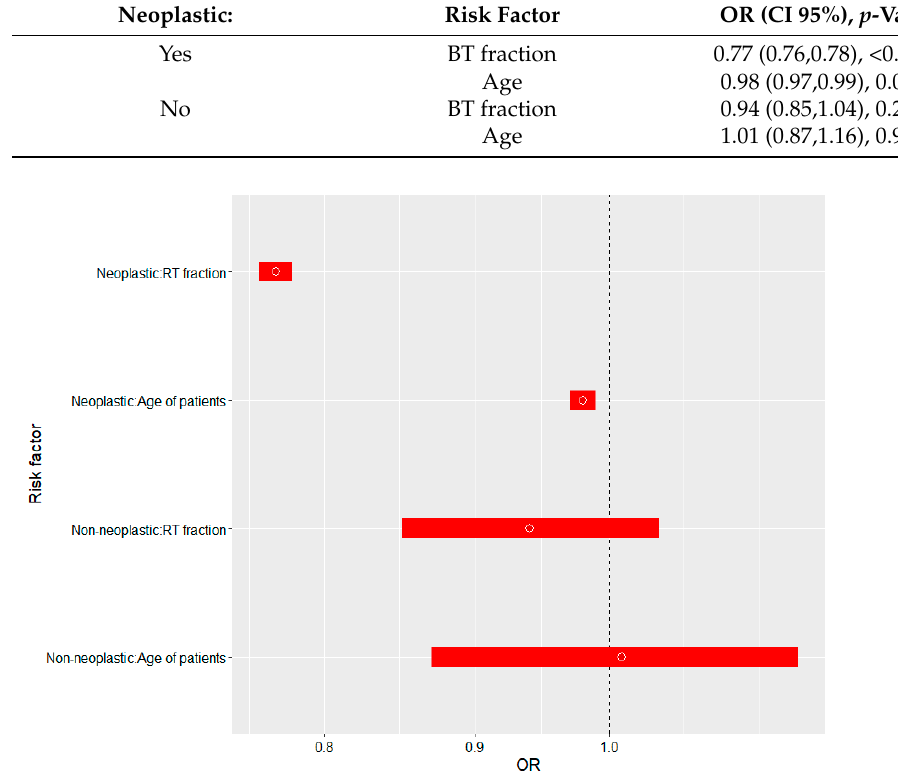
Figure 2. The influence of BT fractions and available risk factors on ranked Tognetti’s clinical (23) and Lallas/Tognetti dermoscopic (8) features of BCCs in correlation with non-neoplastic features (10). Table 5. The influence of BT fractions and available risk factors on ranked Tognetti’s clinical (23) and Lallas/Tognetti’s dermoscopic (8) features of BCCs.